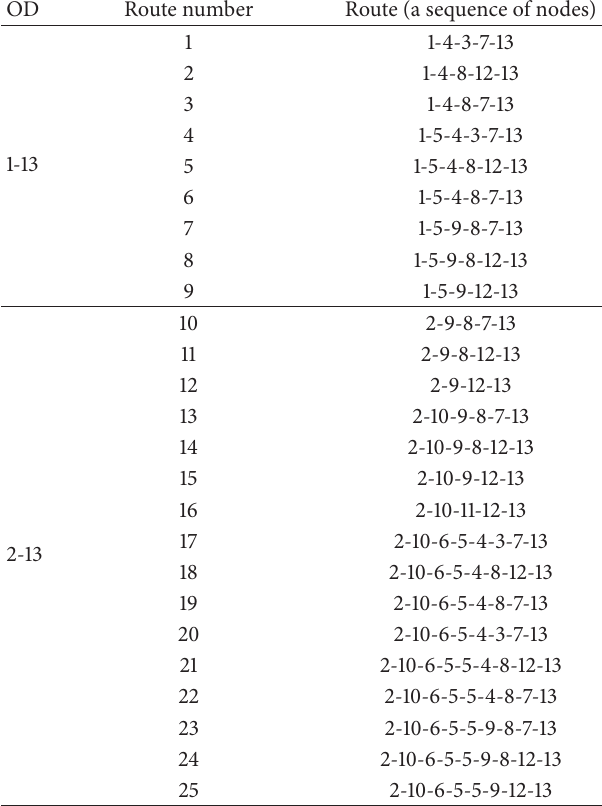
Table 3: Available routes between each evacuation OD. OD Route number